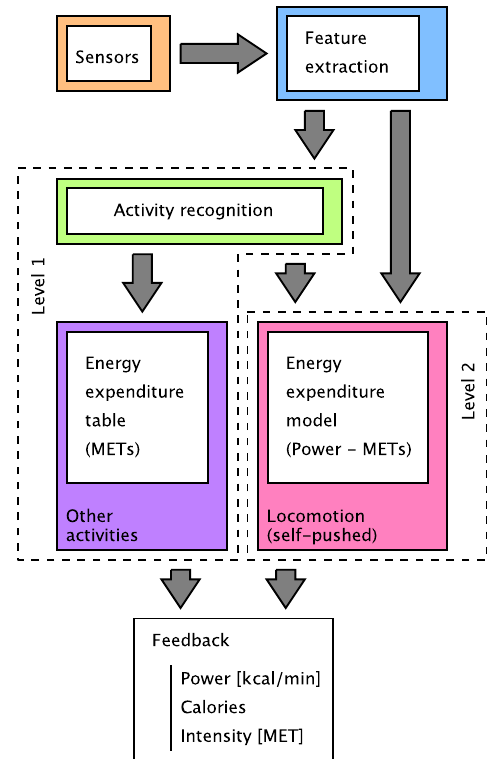
Figure 2. Block diagram of the ActiDote setup The ActiDote system implements two levels of data- driven modelling. The first level is a classification model that must recognize which type of activity is being done by the wheelchair user (green block in Figure 2). Hence, it is possible to use pre-defined tables of physical activity [1] to assess the actual energy expenditure of the user in near real-time. The second level is a regression model that is triggered only when locomotion takes place (see pink block in Figure 2), and must estimate the energy expenditure of the user from the information provided by some sensors installed on the wheelchair and/or worn by the